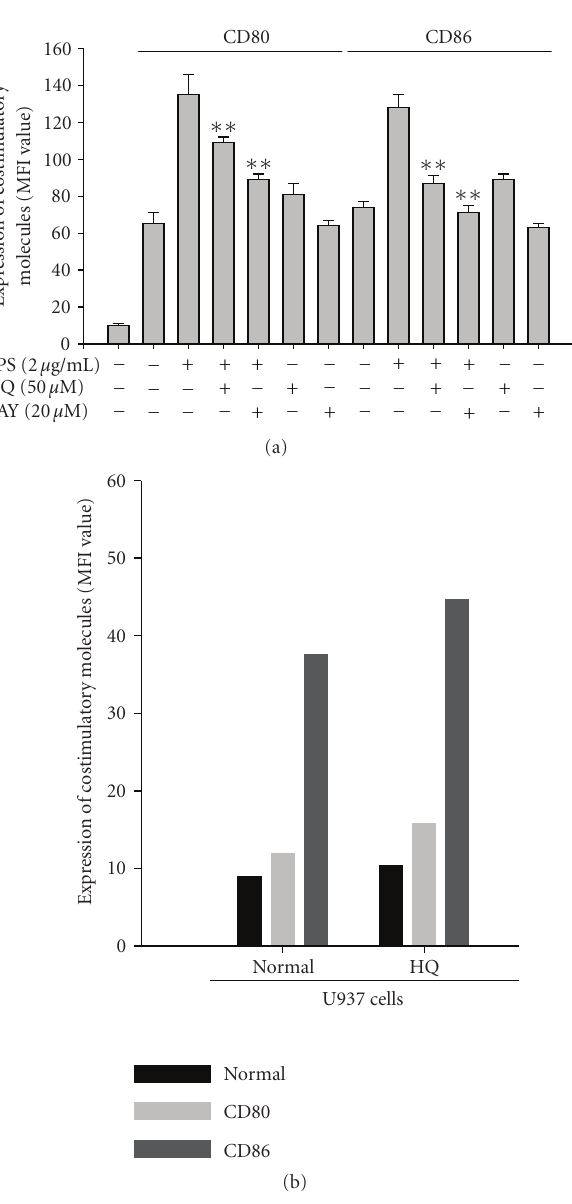
Figure 6: E ff ect of hydroquinone on surface expression of costimu- latory molecules. (a) and (b) RAW264.7 or U937 cells (1 × 10 6 ) were incubated with indicated concentrations of HQ (hydroquinone) in the presence or absence of LPS (2 μ g/mL) for 24 hours. The surface expression of CD80 and CD86 was determined by flow cytometric analysis as described in Section 2. ∗∗ p < . 01 represents significant di ff erence as compared to control.